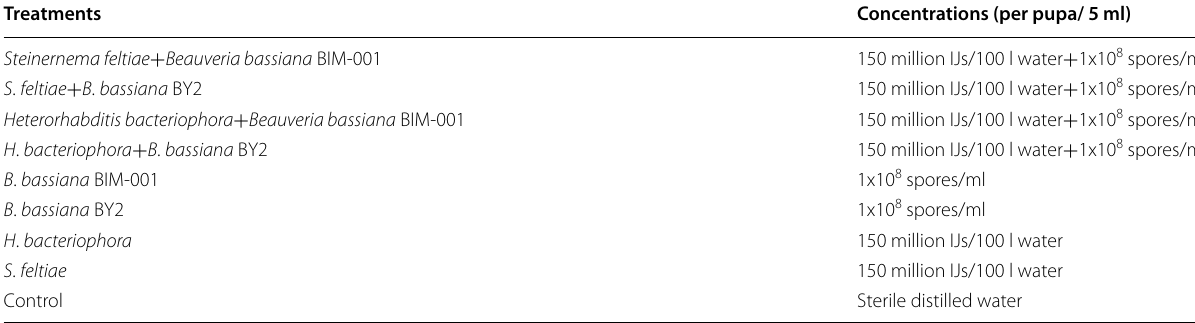
Table 2 Application concentrations of entomopathogenic fungi and nematodes in experiment 2